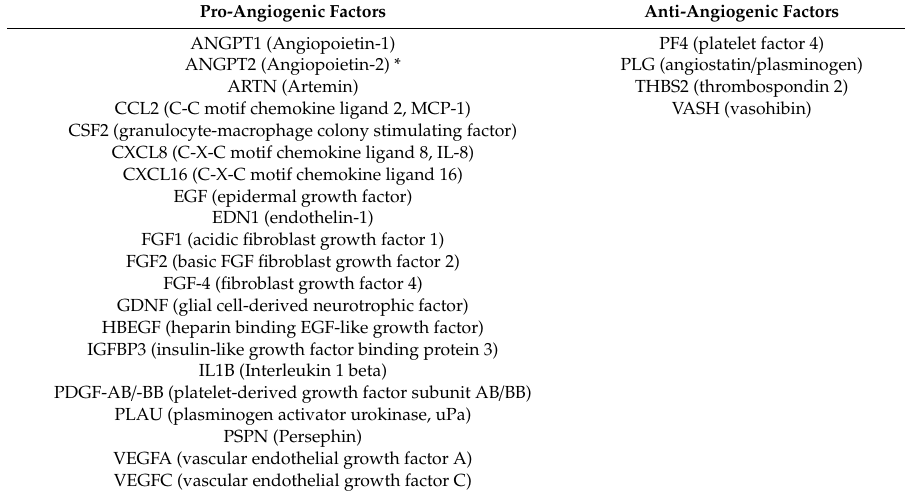
Table 1. Angiogenic factors induced by H. pylori with a fold-change of ≥ 1.5 (siNS_I / siNS_U).